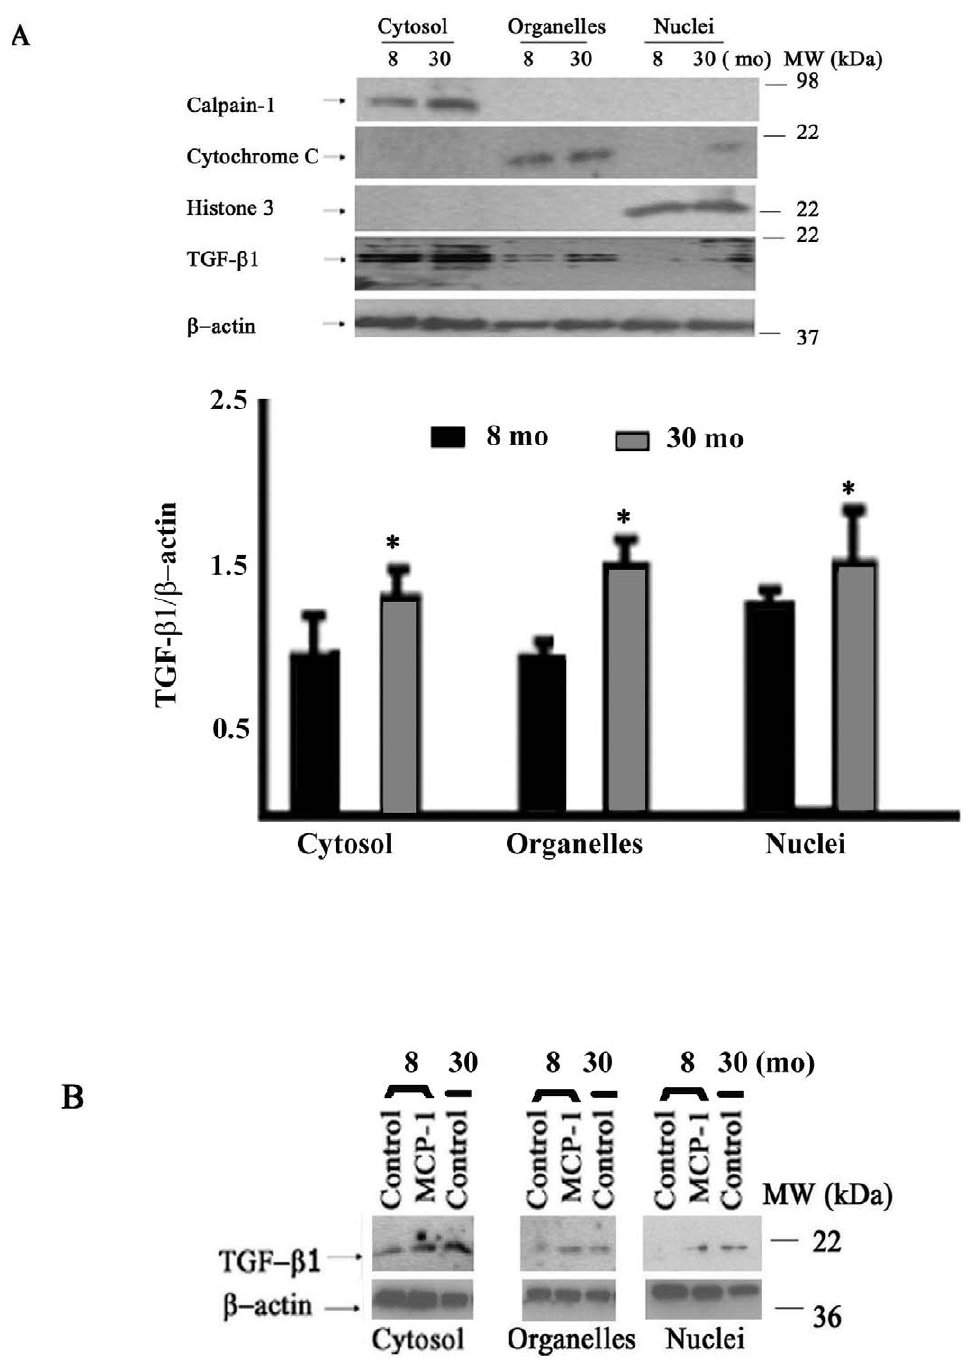
Figure 2. Age effects on subcellular distribution of TGF- b 1. A. Western blots of TGF- b 1 subcellular fractions with aging (upper panels) and average data of subcellular TGF- Y 1 protein fractions lower panel). B. Representative Western blots of TGF- b 1 subcellular fractions with aging and MCP-1 treatment. Similar results were obtained from at least 3 separate experiments. Early passage young and old VSMC were treated with or without MCP-1 (50 ng/ml) for 24 hours. *p , 0.05, old vs.